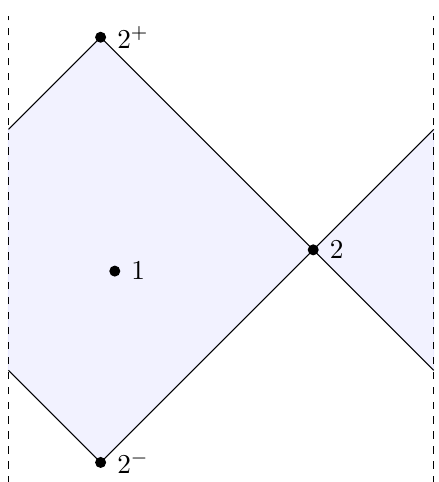
Figure 3. 1 is spacelike from 2 (1 (cid:25) 2) if and only if 1 is in the future of 2 (cid:0) and the past of 2 + (2 (cid:0) < 1 < 2 + ). The (cid:12)gure shows the Lorentzian cylinder in 2-dimensions. The dashed lines should be